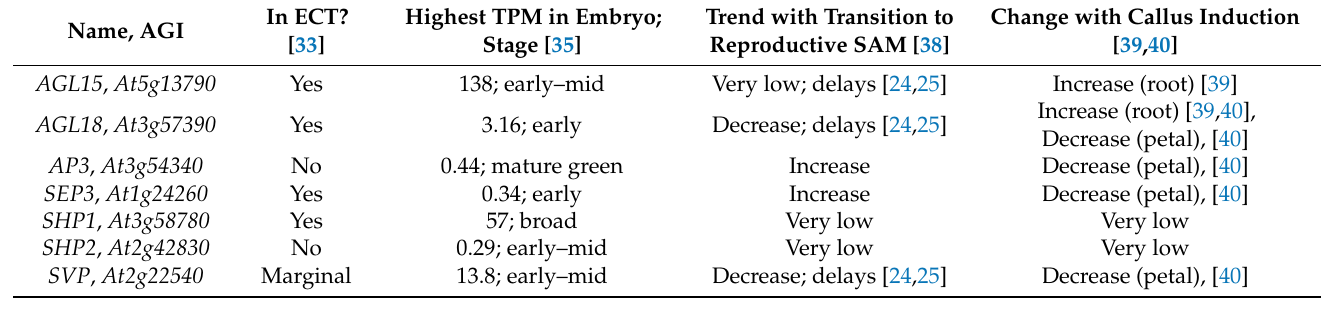
Table 1. Expression patterns for MADS-box genes that are responsive to different forms of AGL15 from BAR eFP [34]. Data from analysis of mutants and overexpressors is included for the transition to reproductive development.